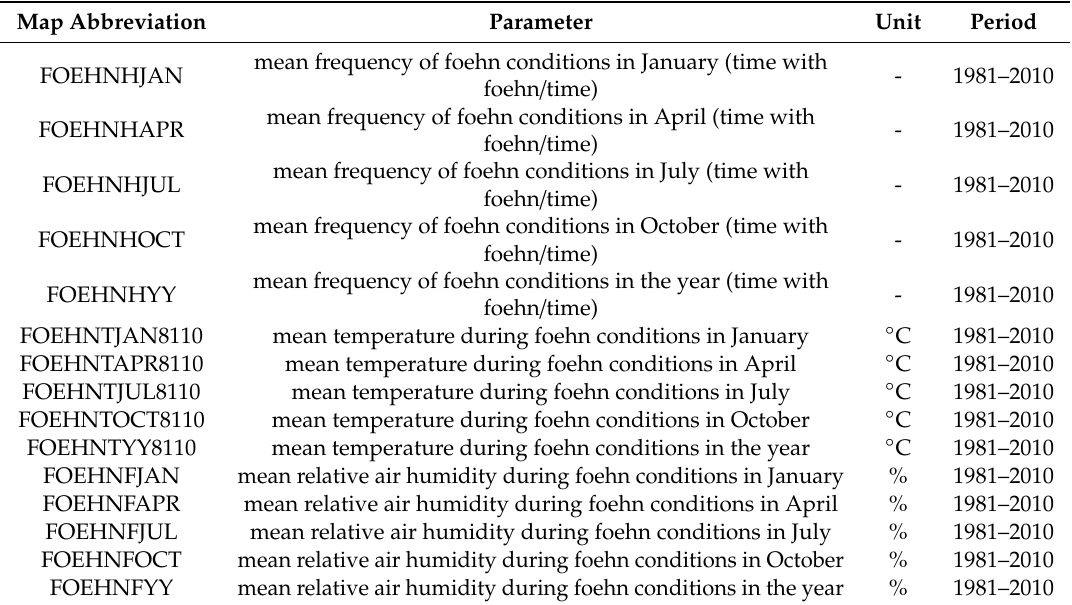
Figure 3. Annual frequency of foehn condition (left) and mean annual relative air humidity during foehn conditions (right) in the period 1981–2010. Table 6. Resulting maps of foehn conditions.